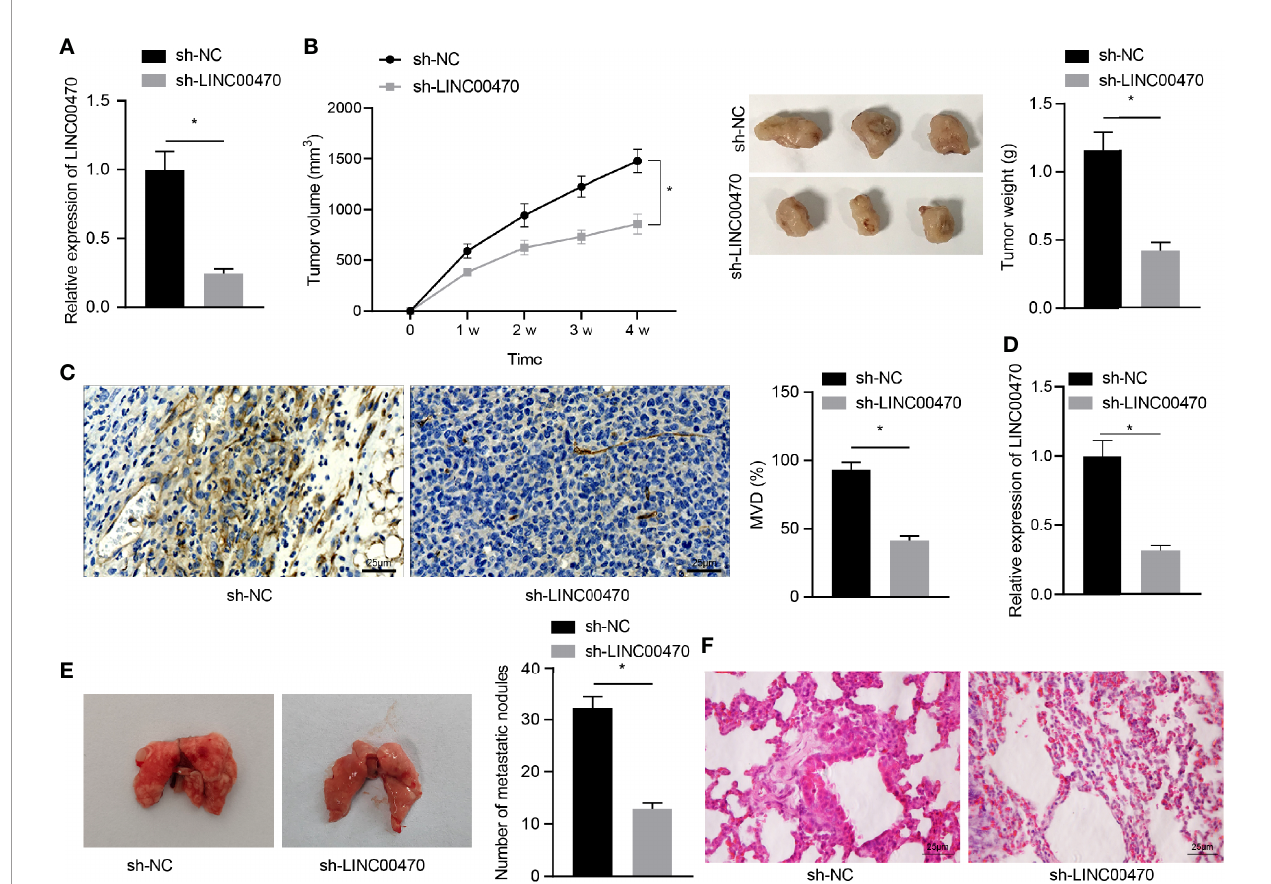
FIGURE 3 | Depletion of LINC00470 could restrain the angiogenesis and metastasis of EC cells in vivo . Nude mouse models of tumor formation and metastasis were established through injection of KLE cells infected with lentivirus carrying sh-NC or sh-LINC00470. (A) RT-qPCR determination of the expression of LINC00470 in the tumor tissues of mice from the tumor formation model. (B) Growth curves, solid maps, and weight of the tumors. (C) Microvessel density, scale bar = 25 m m. (D) LINC00470 expression in tumor tissues of mice from the tumor metastasis model determined by RT-qPCR. (E) Visual observation of lung metastases and counting of metastatic nodules. (F) Metastasis of lung tissue assessed by HE staining, scale bar = 25 m m. The experimental data were expressed as mean ± standard deviation, t -test was used for data comparison between two groups, and repeated measures ANOVA was used for comparison between different time points followed by Bonferroni ’ s post hoc test, * p < 0.05, N =